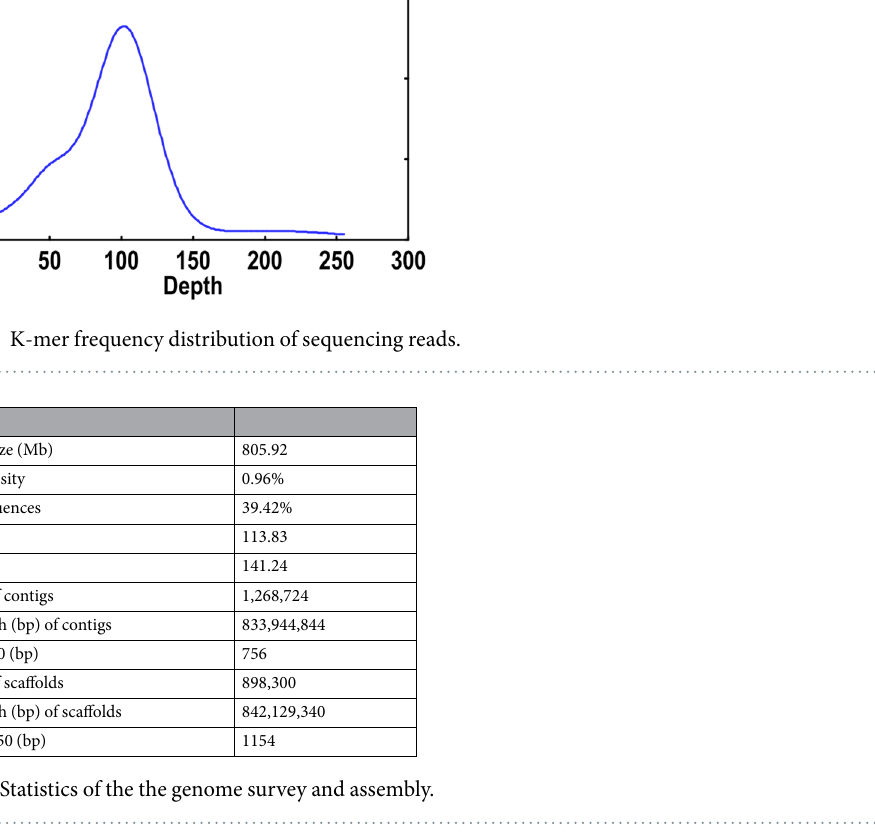
Table S1. QTL analysis was carried out using the interval mapping method and multiple-QTL model mapping (MQM) methods in the program MapQTL 4.0 software as described 47, 48 . Composite interval mapping (CIM) was adopted with 1 cM walking speed. Two-LOD support intervals were constructed as 95% confidence intervals 49 . Likelihood-ratio statistic (LOD) with a minimum score of 3.0 was used to declare the presence for each significant QTL in a particular genomic region, which was determined using 1,000 permutations. The phenotypic variance explained ( PVE ) was also calculated in MapQTL4.0 based on the population variance in the mapping population. The genes located in the QTL regions were considered growth-related genes, which were identified by the integrated map and QTL mapping. Firstly, by finding the markers in the QTL regions. Secondly, to verify whether these markers could be compared to the genomic scaffolds/contigs or transcriptome unigenes. And thirdly, to check whether these sequences could be explicitly annotated via blastx with public databases.